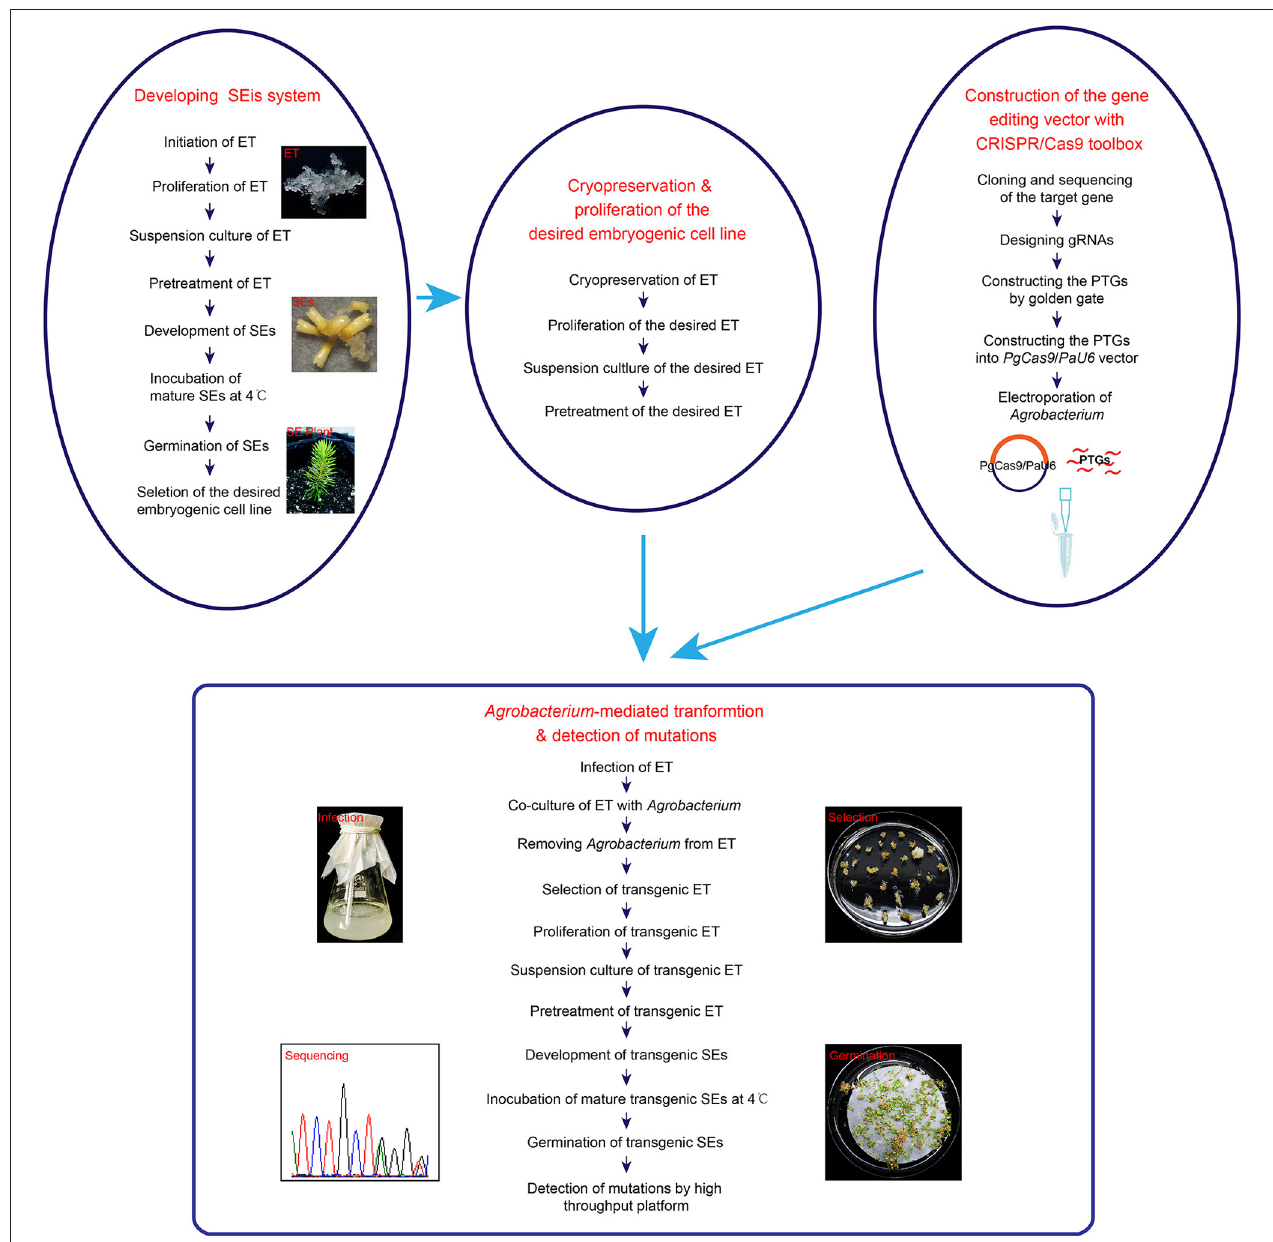
FIGURE 4 | The process of somatic embryogenesis (SEis) and genome editing in Picea glauca . The procedure of developing a SEis system and genome editing with the desired embryogenic cell line is shown in this diagram. ET, SEis, SEs, and PTGs stand for embryogenic tissue, somatic embryogenesis, somatic embryos, and polycistronic tRNA-gRNAs,